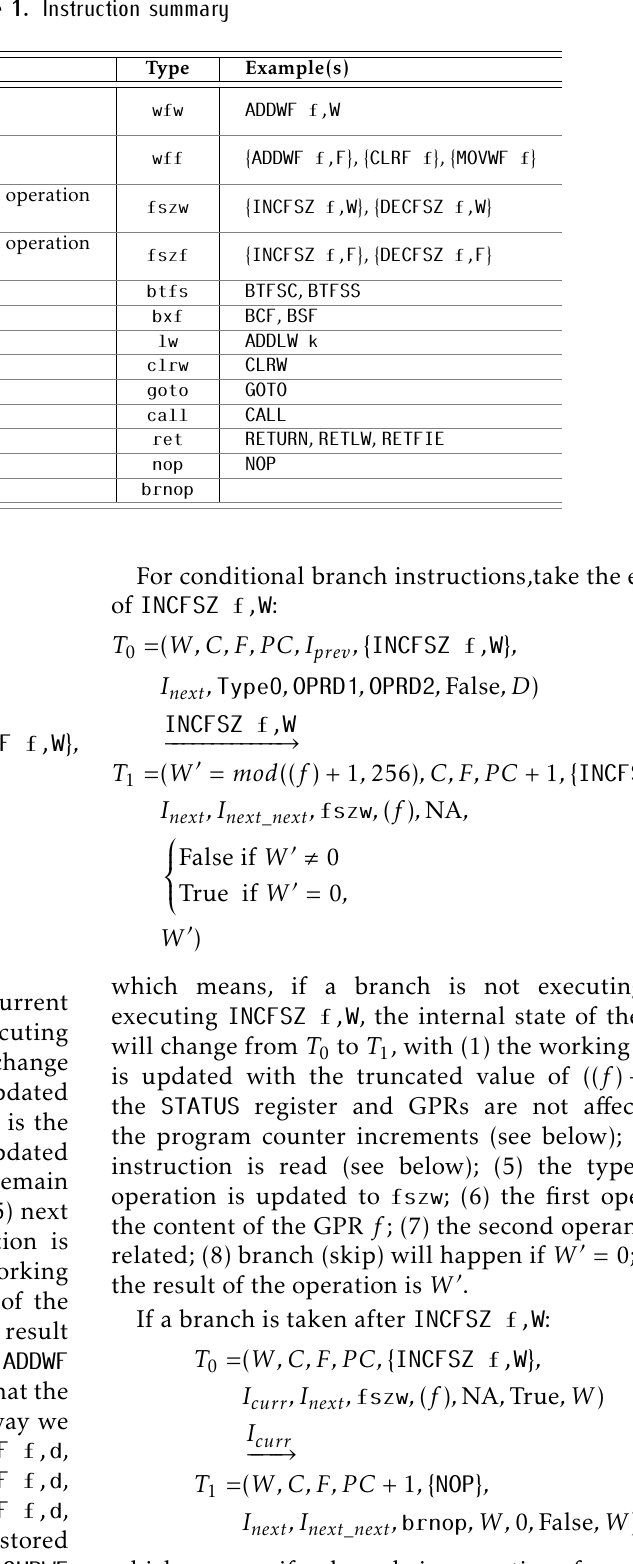
Table 1. Instruction